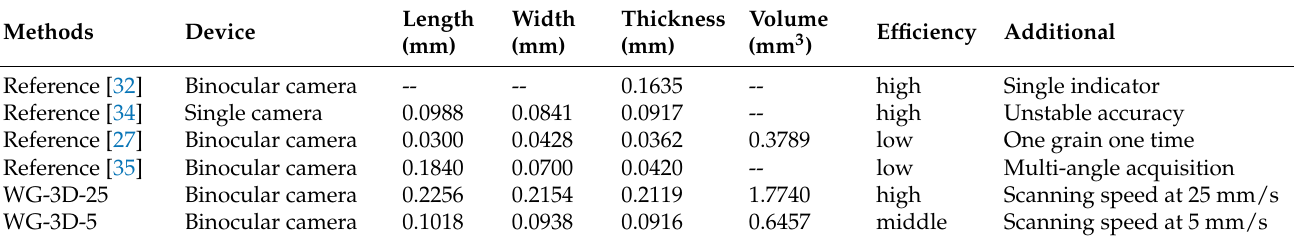
Table 4. Comparative results of relevant